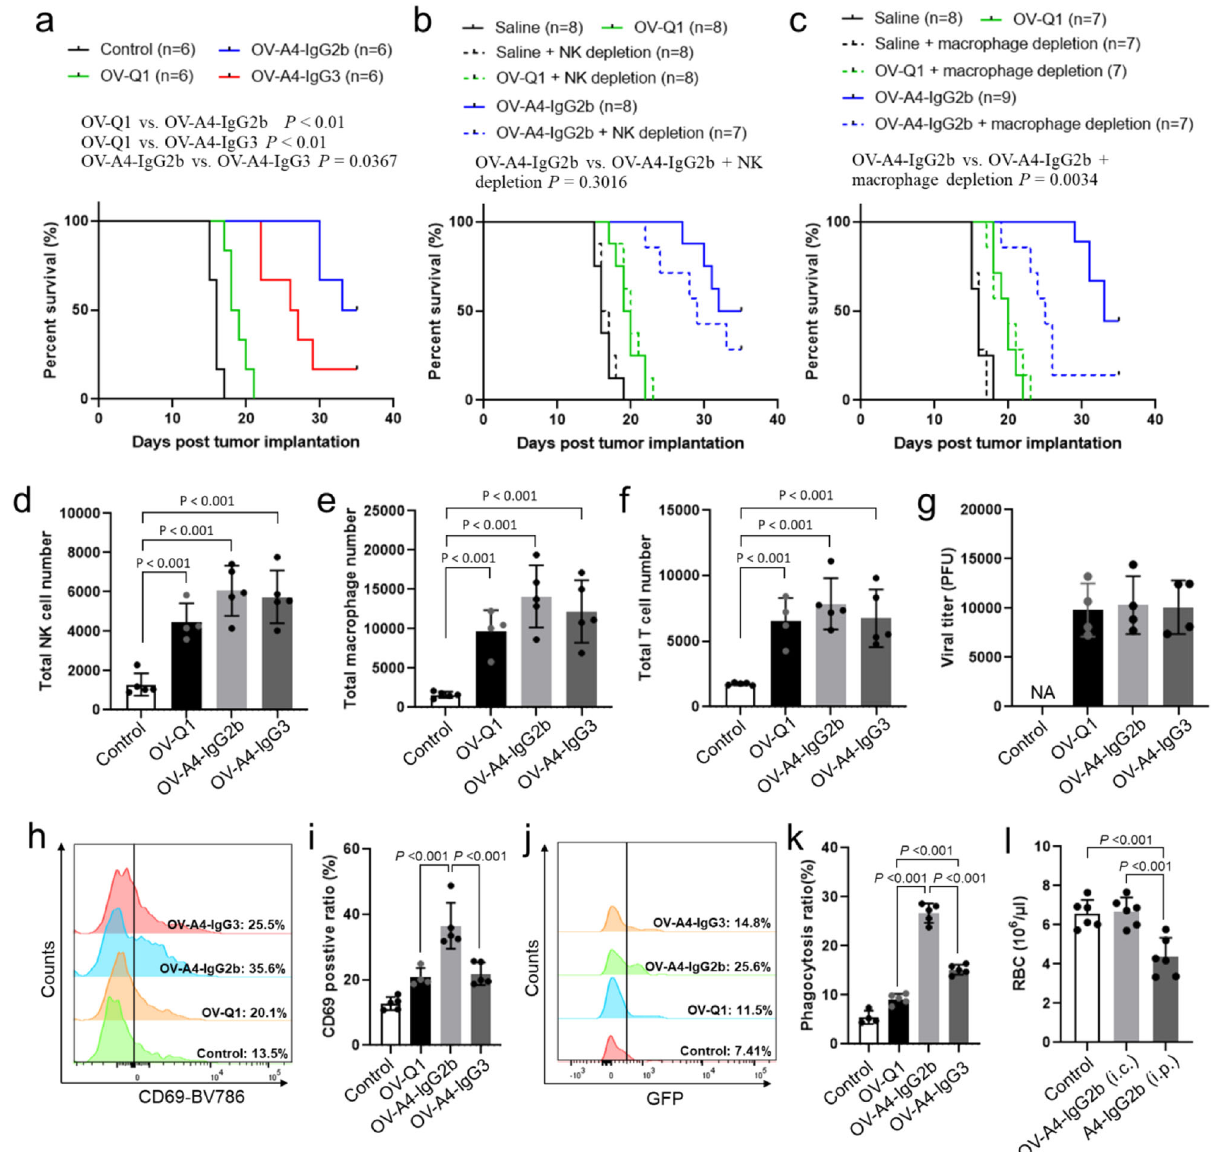
tumor-bearing C57BL/6 immunocompetent mice treated with vehicle control, OV-Q1, OV-A4-IgG2b, or OV-4-IgG3. b Survival of CT2A tumor-bearing C57BL/6 immunocompetent mice treated with vehicle control, OV-Q1, or OV-A4-IgG2b in the presence or absence of NK cell depletion. c Survival of CT2A tumor-bearing C57BL/6 immunocompetent mice treated with vehicle control, OV-Q1, or OV-A4-IgG2b in the presence or absence of macrophage depletion. Survival was estimated by the Kaplan – Meier method and compared by two-side log-rank test. d − f Intracranial in fi ltration of NK cells (CD3 − NKp46 + ) ( d ), macrophages (F4/80 + CD45highCD11b + ) ( e ), and T cells (CD3 + NKp46 − ) ( f ) in CT2A-bearing mice measured by fl ow